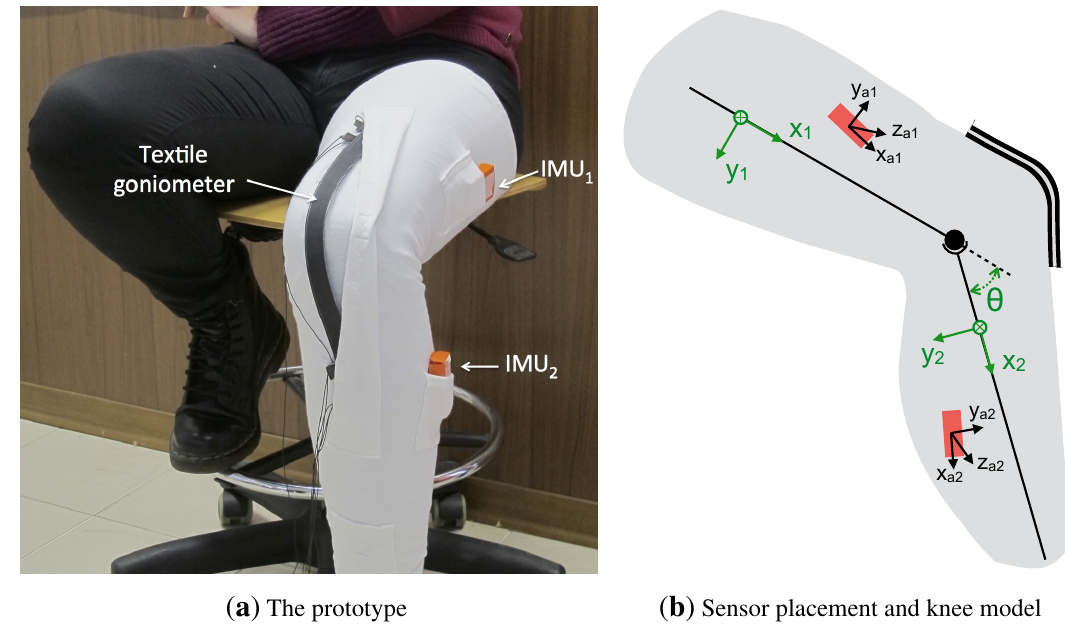
Figure 1. Sensing prototype and sensor placement around the knee joint. ( a ) A double-layer knitted piezoresistive fabrics (KPF) goniometer and two inertial measurement units (IMUs) were applied to the knee band; ( b ) A geometrical scheme of the reference frames fixed with the body segments and the IMUs. The knee was simply modeled as a hinge joint, and the flexion-extension angle ( θ ) was defined as the angle between the two consecutive model segments ( i.e ., the angle between the x unit vectors of the Ψ frames). IMU and accelerometer reference frames ( Ψ are not aligned with the corresponding segment reference